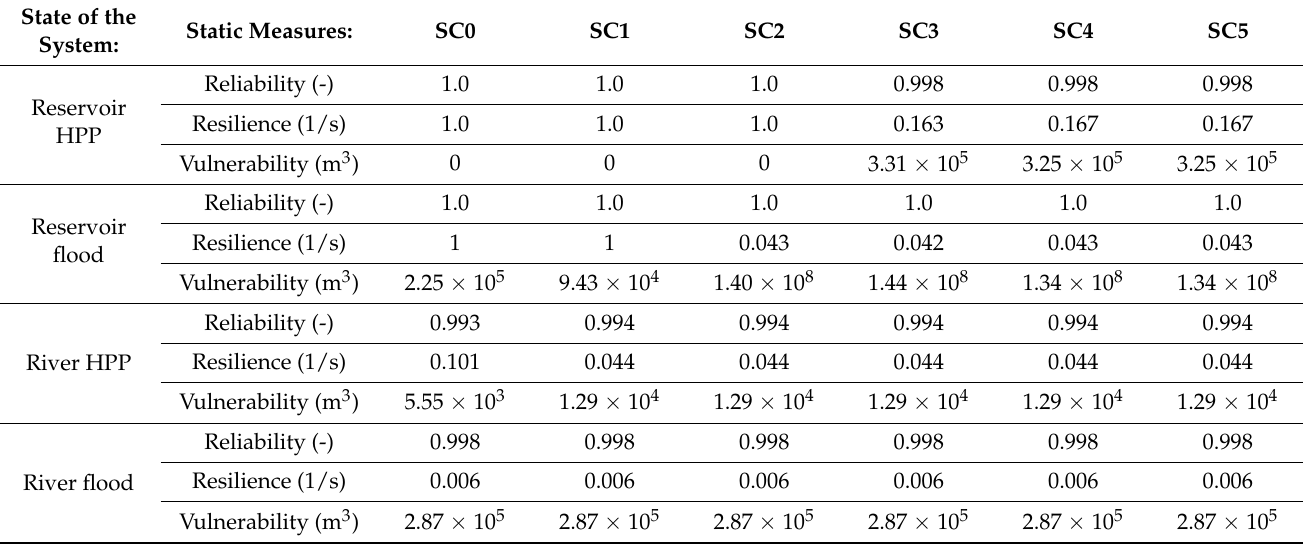
Table 5. Static risk measures (reliability, resilience, vulnerability) of the Pirot reservoir